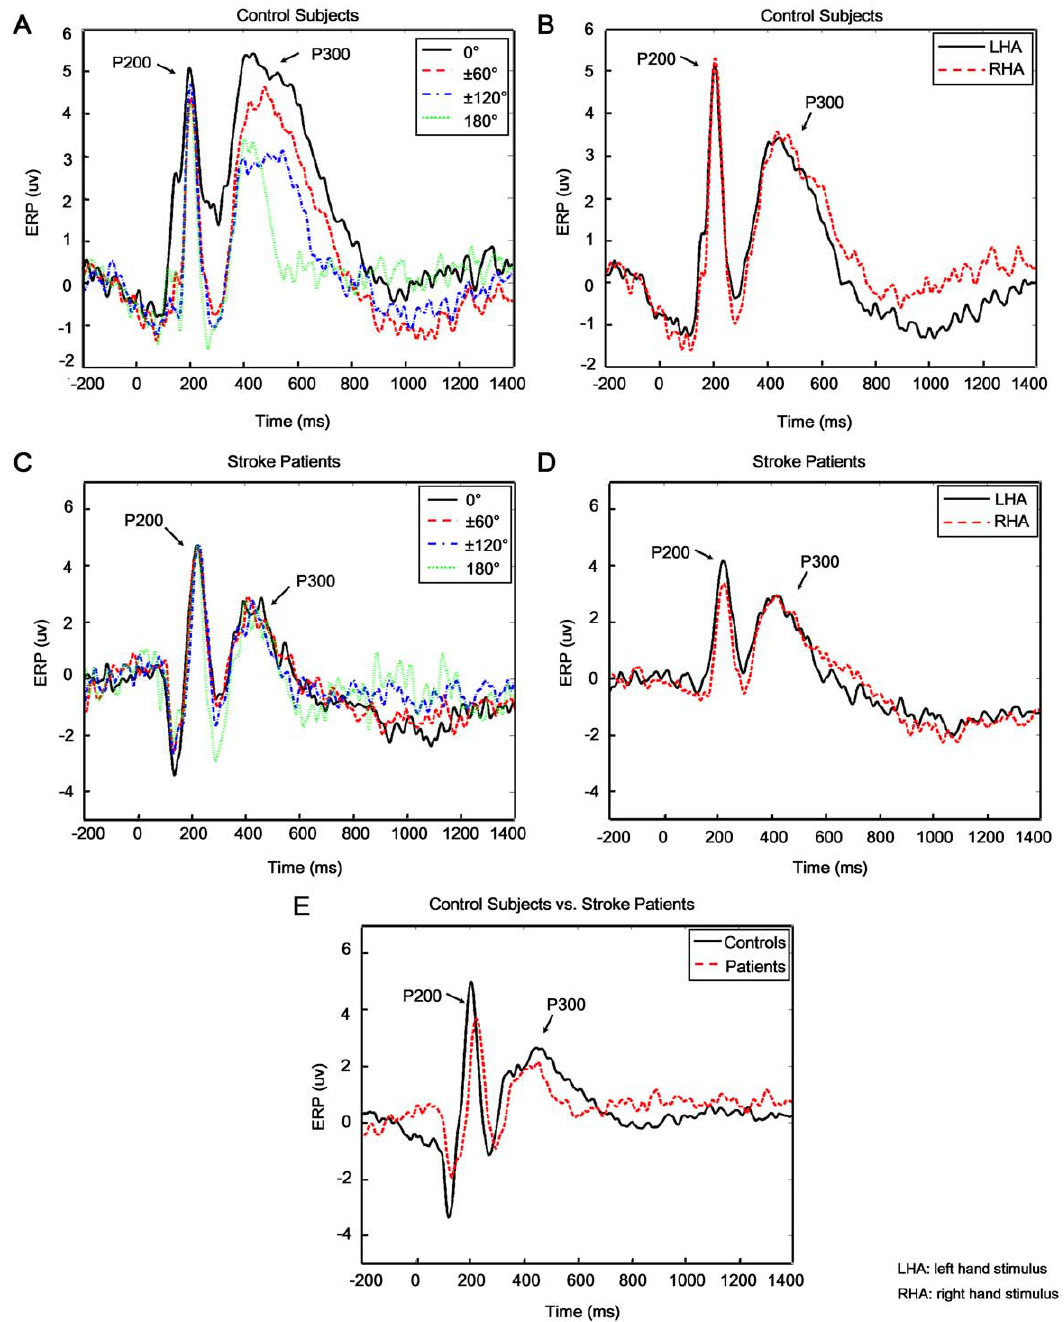
Figure 3. Event-related potential (ERP) results. A and B: Grand-averaged ERP curves at P4 electrode for control subjects were shown in regard to ANGLE and HAND factors respectively. C and D: ERP curves at P4 electrode for stroke patients also with respect to ANGLE and Hand factors respectively. E: Comparison of grand-averaged ERP at P4 electrode between control subjects and stroke patients was shown. Stimuli were displayed on monitor at 0 ms. Baseline was from 2 200 ms to 0 ms, and two significant important components, i.e., P200 (0–300 ms) and P300 (300–800 ms) were indicated by arrows. No significant difference of P300 amplitude between 60 u vs. 300 u (p=0.384), 120 u vs. 240 u (p=0.293) was observed for all subjects. Thus only four ERP curves of 0 u , 6 60 u , 6 120 u and 180 u were illustrated in A and C. doi:10.1371/journal.pone.0042922.g003 areas was observed in stroke patients, which might lead to the deficiency in hand perception and spatial information encoding in stroke patients. The insignificance of main effect of HAND (F(1,20) =3.046, p = 0.096; Figure 3B for control subjects and D for stroke patients)